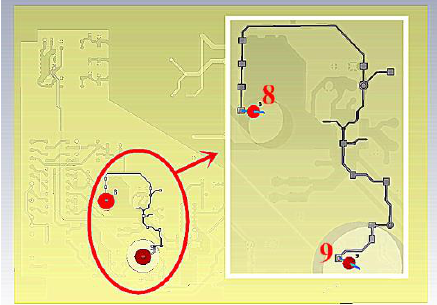
Figure 18. Schematic diagram of the 3.3 V power line.